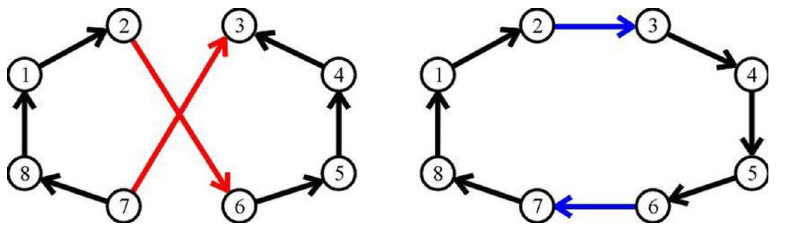
Fig 7. Generating 2-opt